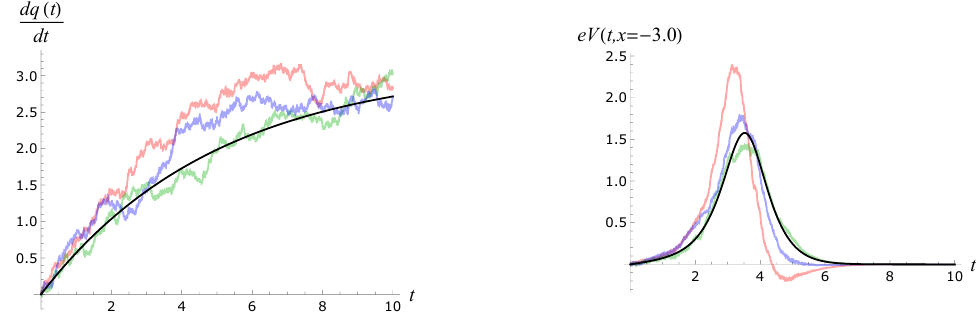
Figure 3: Solutions of the Langevin equation (39) (left panel) and the voltage at a given position x = − 3.0 (right panel) a constant bias current with a parameter set ( m , γ , J , A ) = ( 1.0,0.2,0.8,0.5 ) . Black lines shows the averaged result while the colored (red, green, and blue) ones are three sample